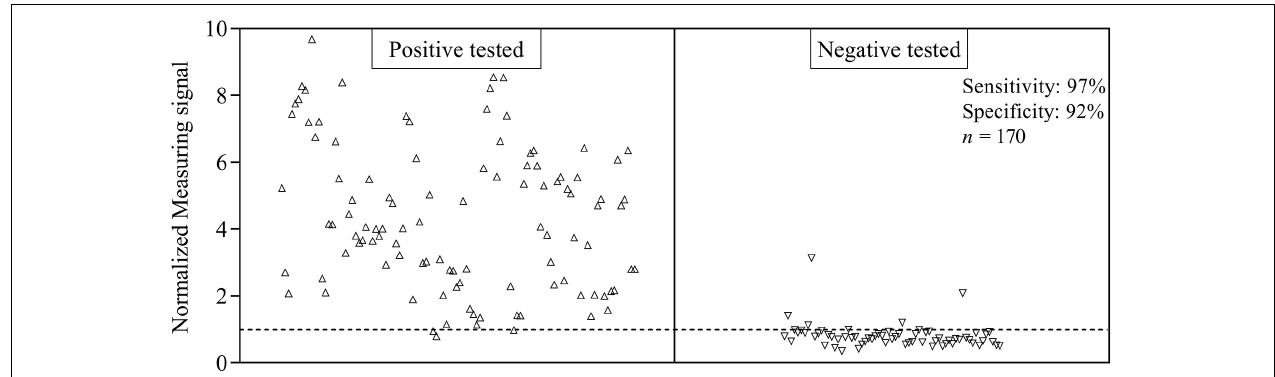
FIGURE 4 | Sensitivity and specificity of magnetic immunodetection-based SARS-CoV-2-specific antibody testing. A total of 170 patient sera were previously tested with certified DiaSorin Liaison SARS-CoV-2 S1/S2 IgG assay in clinical environment for the occurrence of SARS-CoV-2-specific antibodies. Afterward, sera were retested using magnetic immunodetection with SARS-CoV-2 S1-His protein coated and blocked ready-to-use immunofiltration columns (RTU-IFCs). After application of sera, followed by subsequent addition of biotinylated human IgG-specific secondary antibody and streptavidin-functionalized magnetic particles, IFCs were measured using a handheld frequency mixing magnetic detection (FMMD) readout device. Each data point represents a patient serum ( n = 1). Dashed line indicates the threshold defining, whether sera were positive or negative tested using magnetic immunodetection.